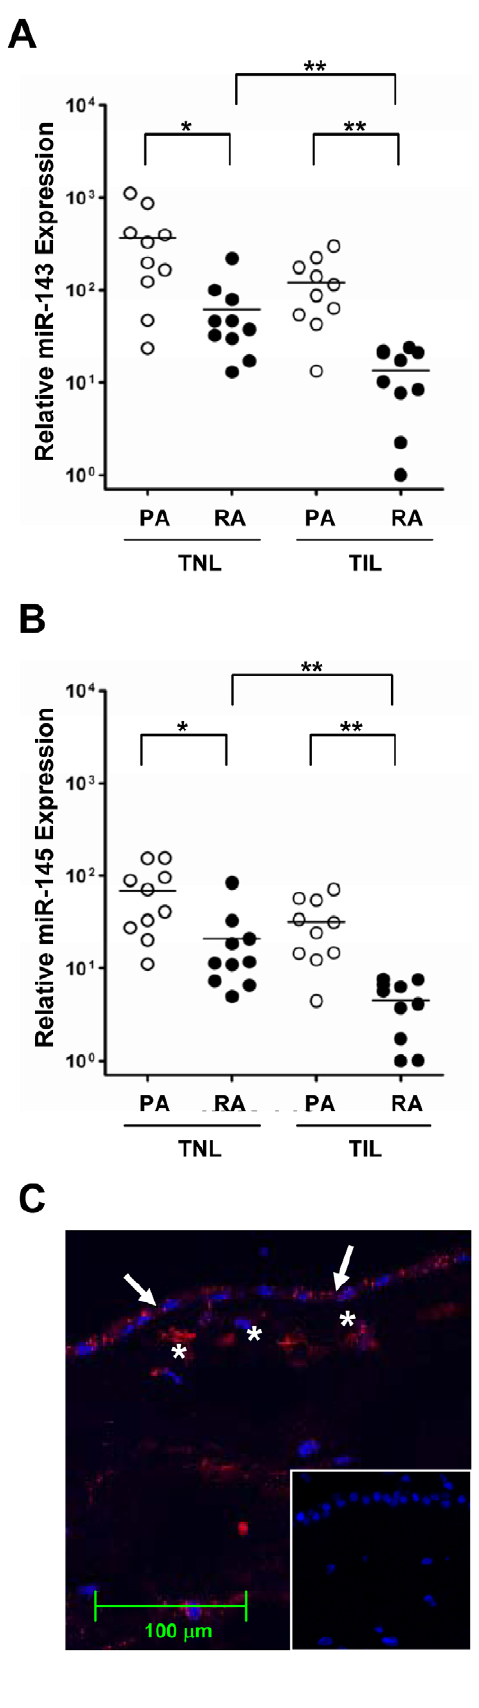
Figure 1. miR-143/miR-145 cluster expression in PA and RA. A, qRT-PCR analysis of miR-143 expression in PA and RA obtained from women at term not in labor (TNL; n=10) and in labor (TIL; n=10) to confirm microarray results. TNL cases are composed of 5 cases subjected to microarray analysis and 5 additional cases, while TIL cases are composed of 4 cases used in the microarray analysis and 6 additional cases because of RNA availability. miR-143 expression is significantly higher in the PA than in the RA in both groups, and its expression in the RA is significantly higher in TIL cases than in TNL cases. *, p , 0.05 **, p , 0.005. B, The differential expression patterns of miR-145 are basically identical to those of miR-143. C, In situ hybridization for miR-143 in the RA obtained from a TNL case. Hybridization signals are readily detected in the amnion epithelial cells (arrows) and mesenchymal cells (asterisks). Inset shows scrambled LNA in situ hybridization results used for negative control. Original magnification 6 400. PA: placental amnion. RA: reflected